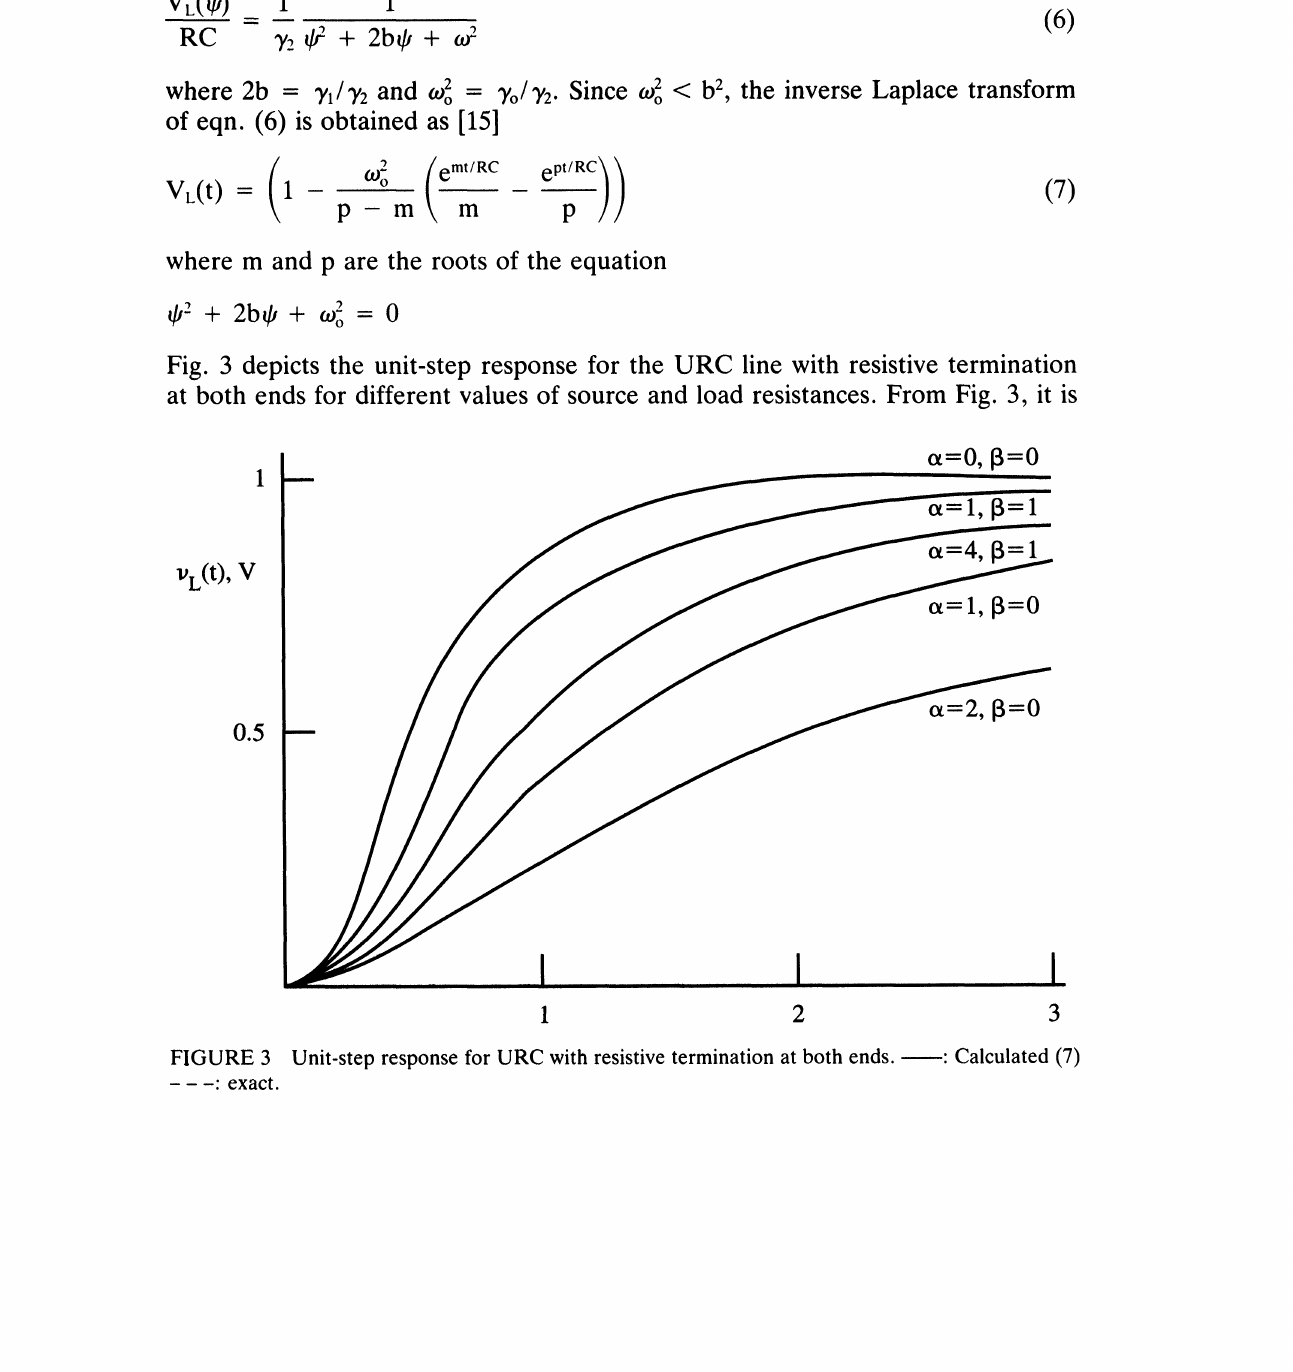
1 2 3 Unit-step response for URC with resistive termination at both ends. : Calculated exact.